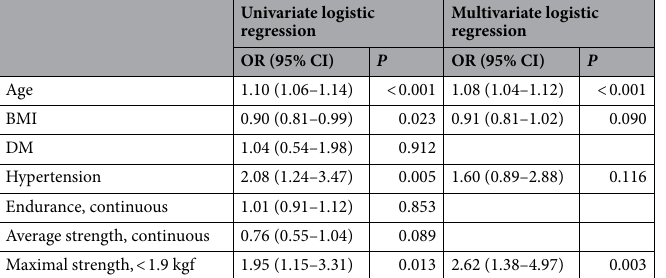
Multivariate logistic